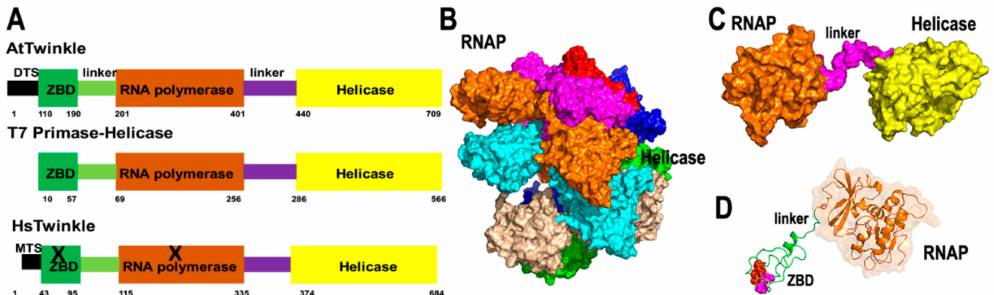
Figure 1. AtTwinkle is a homolog of bacteriophage T7 primase-helicase and mitochondrial Twinkle. ( A ) Schematic representation of the bifunctional T7 primase-helicase in comparison to AtTwinkle and human Twinkle. T7 primase-helicase and AtTwinkle contain the conserved motifs necessary for primase and helicase activities, whereas human Twinkle is inactive as a primase. ( B ) Homology model of AtTwinkle showing its RNA polymerase domain and helicase modules with basis on the crystal structure of the heptameric T7 primase-helicase [31]. ( C ) Close view of a monomeric module of the RNAP and helicase of AtTwinkle. ( D ) Close view of the primase module composed of the zinc binding domain (ZBD) and RNAP domain. The conserved cysteines that coordinate the zinc atom are colored in red and